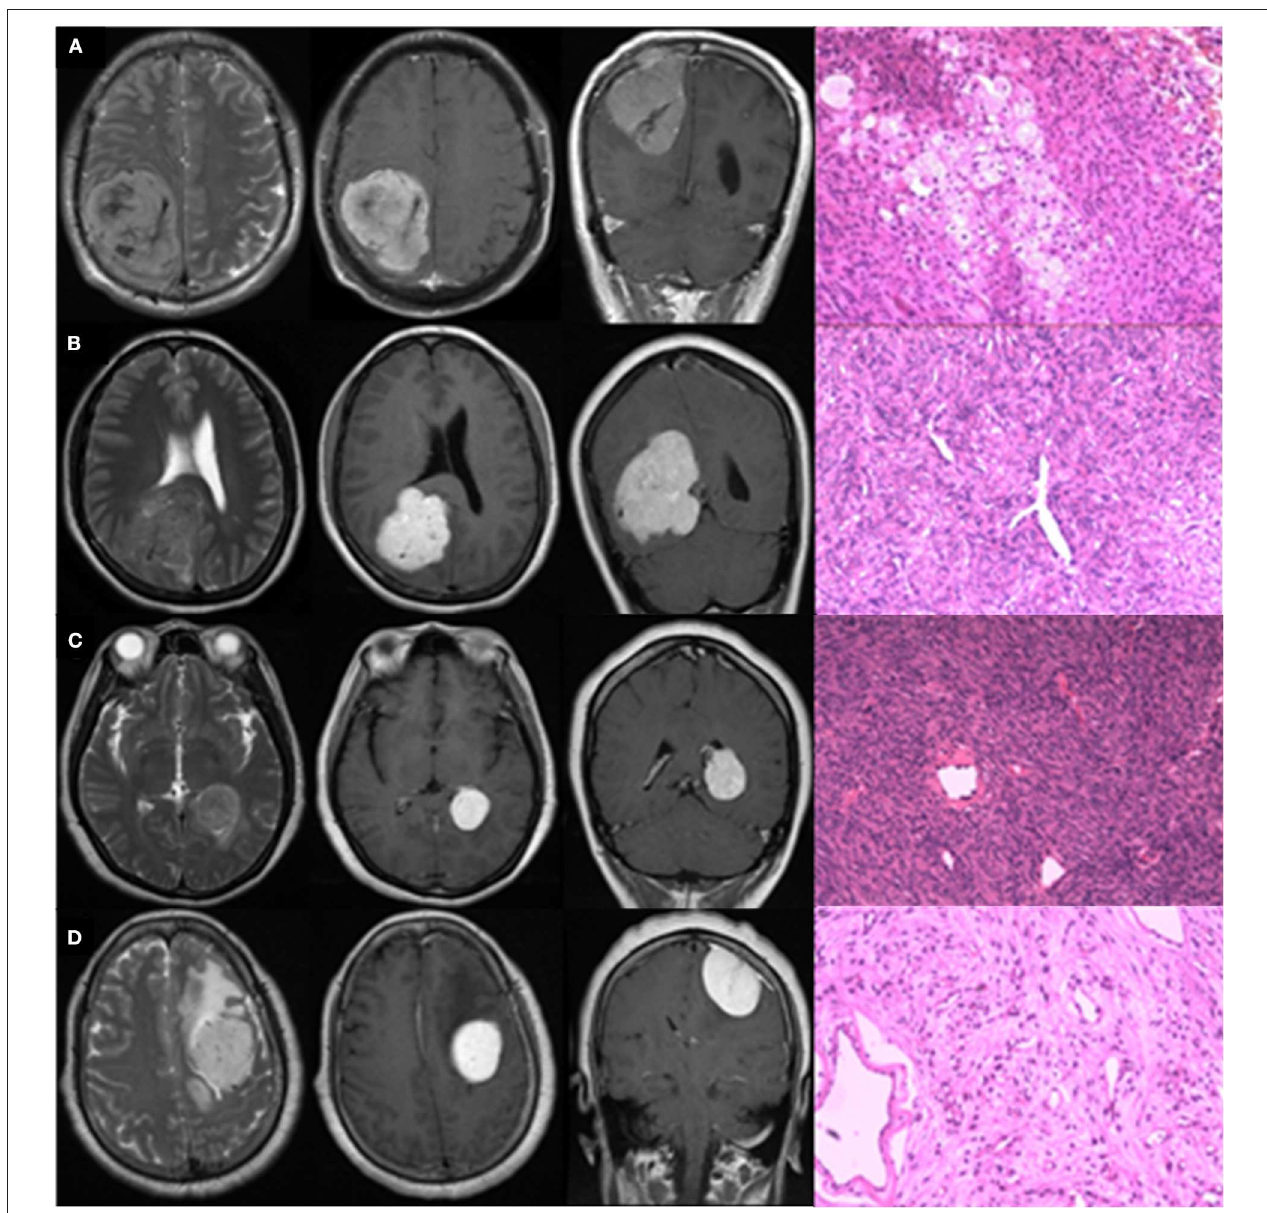
FIGURE 4 | Typical radiologically misdiagnosed cases. The four graphs in row were T2WI in axial view, CE-T1WI in axial and coronal view, and pathological image, respectively. Lesions in Cases (A,B) were supratentorial, posterior, and close to midline in location with internal serpentine signal voids, and absence of peritumoral edema on T2WI; irregular shape, unclear margin, and absence of the dural tail sign on CE-T1WI. Enhancement in Case (A) was heterogeneous, while in Case (B) , it was homogeneous. Lesions in Cases (C,D) were supratentorial and lateral in location with extensive peritumoral edema on T2WI; homogeneous enhancement, regular shape, and clear margin on CE-T1WI. Lesion in Case (C) grew in the lateral ventricle without apparent blood supply. Lesion in Case (D) located in the frontal, presenting with internal serpentine signal voids and clear dural tail sign. Actually, Cases (A,D) were pathologically confirmed meningiomas; Cases (B,C) were pathologically confirmed